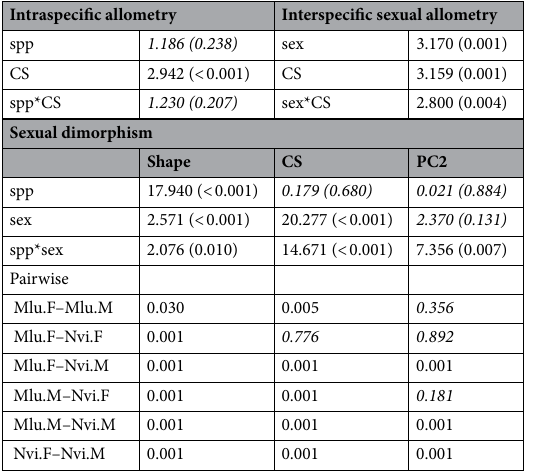
Table 1. Factor interactions in mandible size and shape. Results from the Procrustes ANCOVAs for species and sex with centroid size as covariate, and of the two-way Procrustes ANOVA (mandible shape) and non- parametric ANOVA (centroid size) with species and sex as categorical variables. For each factor, Goodall’s F values are provided together with its associated p value (in brackets), with non-significant p value in italics. Results of post-hoc pairwise tests used to assess differences between species-sex pairs are also provided. CS, centroid size; F, female; M, male; Mlu, European mink; Nvi, American mink; spp, species; sex*CS, interaction between sex and size; spp*CS, interaction between species and size; spp*sex, interaction between species and